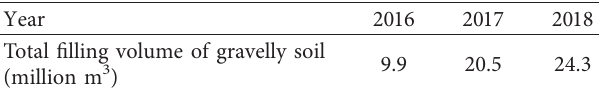
Figure 10: Variation of the negative accumulated air temperature and the frozen depth of the compacted gravelly soil without covering the thermal insulation materials with time from January 9 to 14, 2017 and from January 9 to 14, 2018. (a) Variation of the negative accumulated air temperature. (b) Frozen depth of the compacted gravelly soil without covering the thermal insulation materials. Table 3: Total filling volume of gravelly soil of the dam core wall during the winter